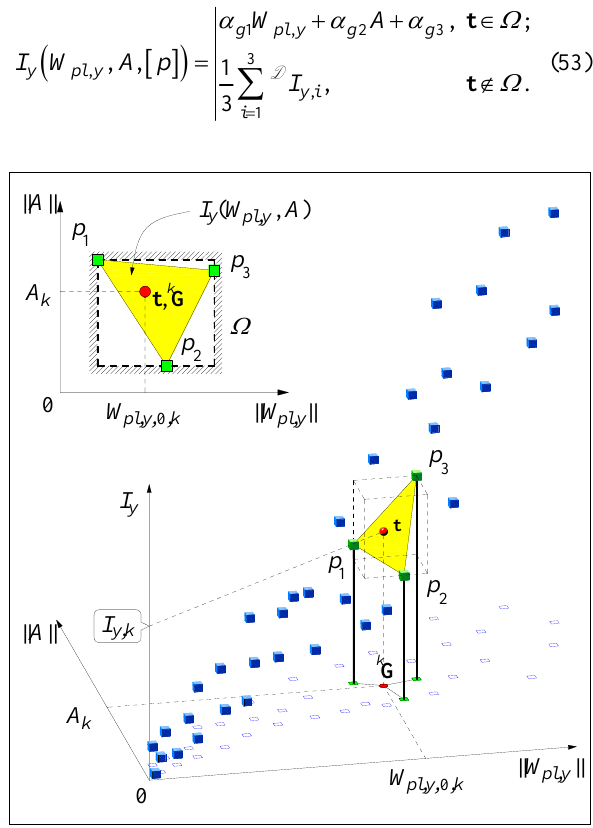
Fig. 10. Interpolation of the inertia moments of cross-sections I y,k of BEAM31